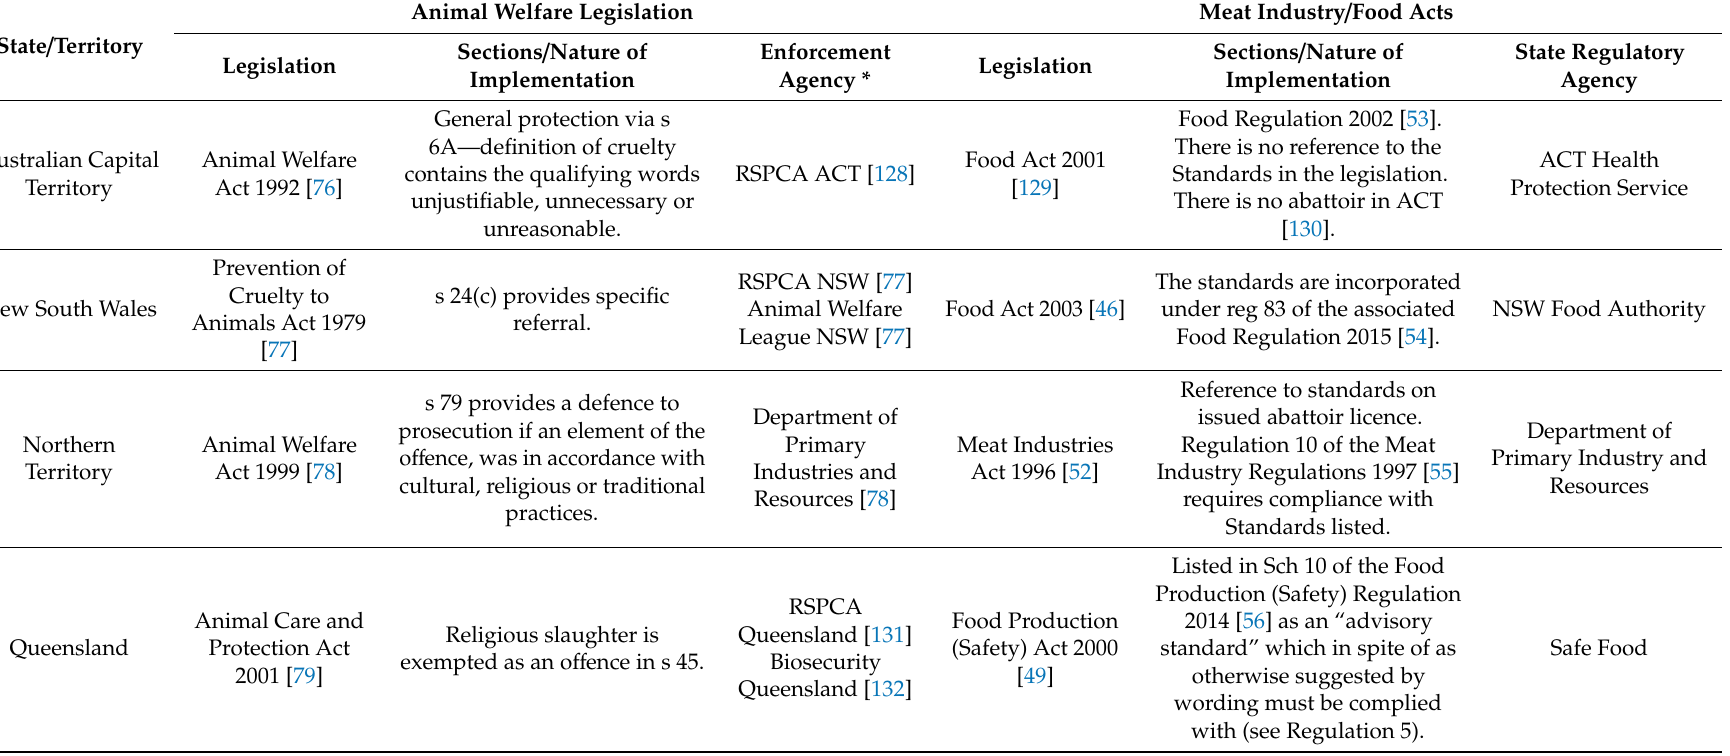
Table 1. Legislation in the Australian states and territories that allows religious slaughter to take place, and mechanism of legal protection / safeguards for the